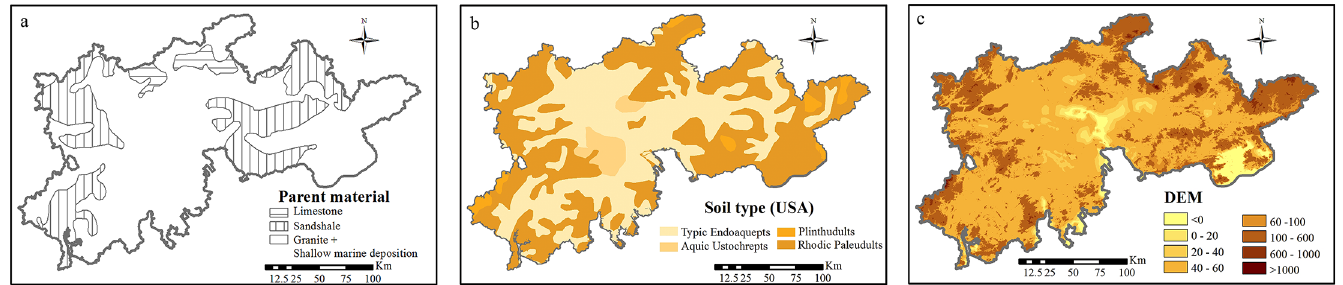
Fig 2. Basic message of the PRD region (a), geological sketch indicating the distribution of parent rocks (b), soil type and (c) DEM.